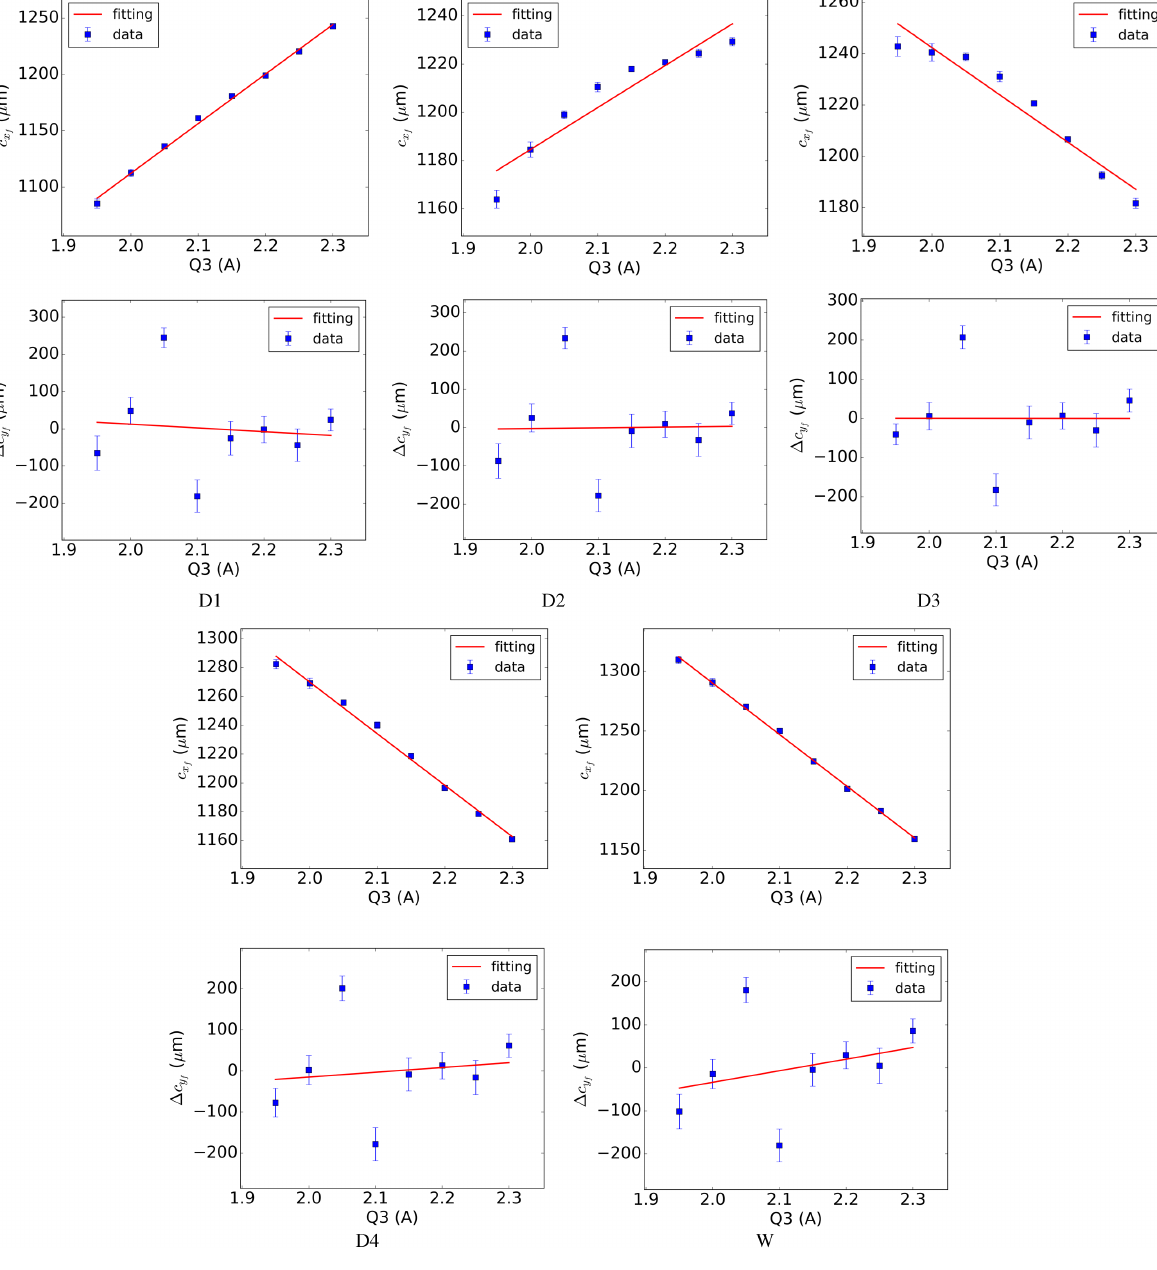
FIG. 14. Fits for each bunch in the train in the horizontal and vertical planes for the No. 170652